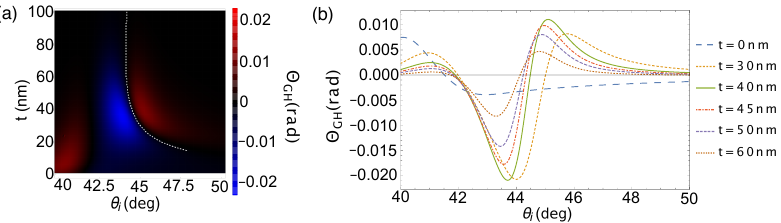
Figure 4. ( a ) Θ GH spectrum for a BK7/Ti/Au/air structure with varying Au film thickness with tightly focused incident beam around the SPR angle; ( b ) and representative plots at several Au